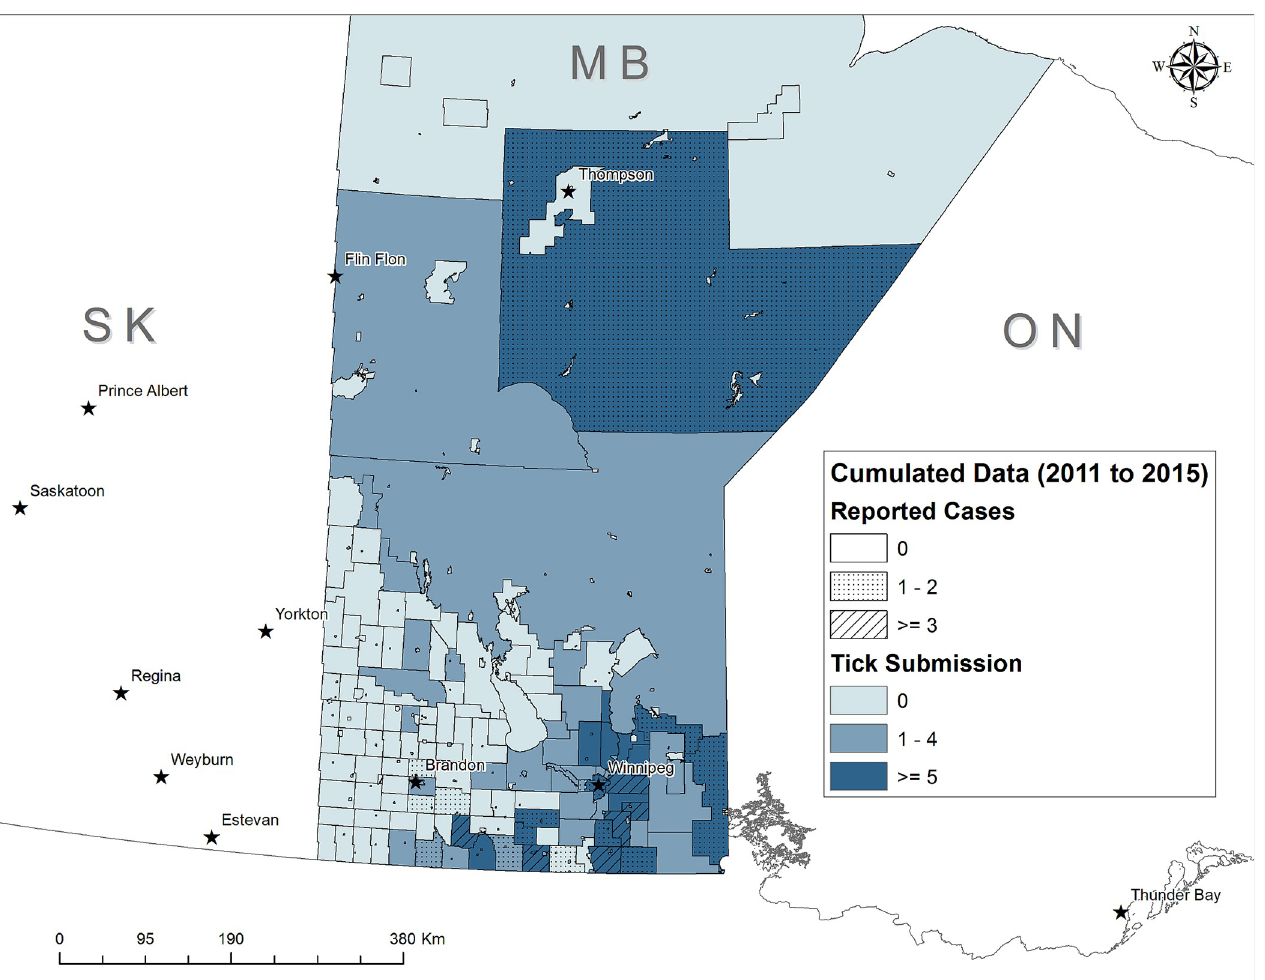
Fig 4. Geographic distribution of passive I . scapularis tick submissions (adults and nymphs) and total number of human Lyme disease cases in CSDs in Manitoba from 2011 to 2015. Dotted CSD are areas with emerging risk (1–2 human Lyme disease cases). Hatched CSD are endemic areas where � 3 Lyme disease cases were acquired. Light blue CSDs are areas where the number of adults and nymphs is < 5, the optimal cut-off point as a predictor of the human Lyme disease risk. Dark blue CSDs are areas where the number of ticks is � 5.